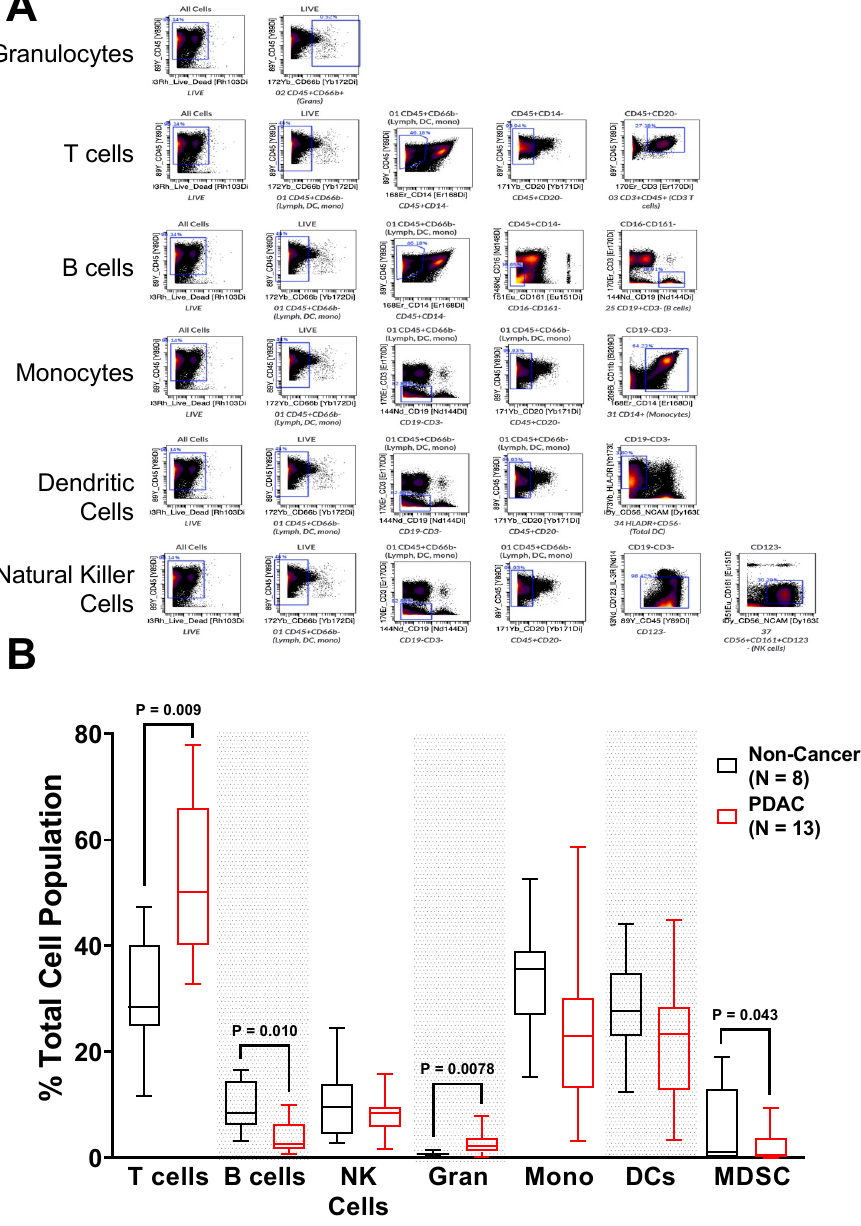
Figure 3. PDAC Patients Have Altered Circulating Immune Populations. Peripheral blood mononu- clear cells (PBMCs) were collected and processed from non-cancer and PDAC patients, stained with isotope-bound antibodies, and analyzed by the mass cytometer. Biological replicates represent staining and analyses of n = 8 non-cancer and n = 13 PDAC patient samples. ( A ) Representative gating for granulocytes, T cells, B cells, monocytes, dendritic cells, and natural killer cells; and ( B ) Quantification of immune populations from non-cancer and PDAC patients. Granulocytes are denoted as Gran, and monocytes are denoted as Mono. Biological replicates represent staining and analyses of each individual sample. Individual biological replicates were combined into box and whisker plots representing the median and interquartile range (25–75%) with whiskers representing the outlying 25%. All statistical comparisons are unpaired t -tests with a Welch’s